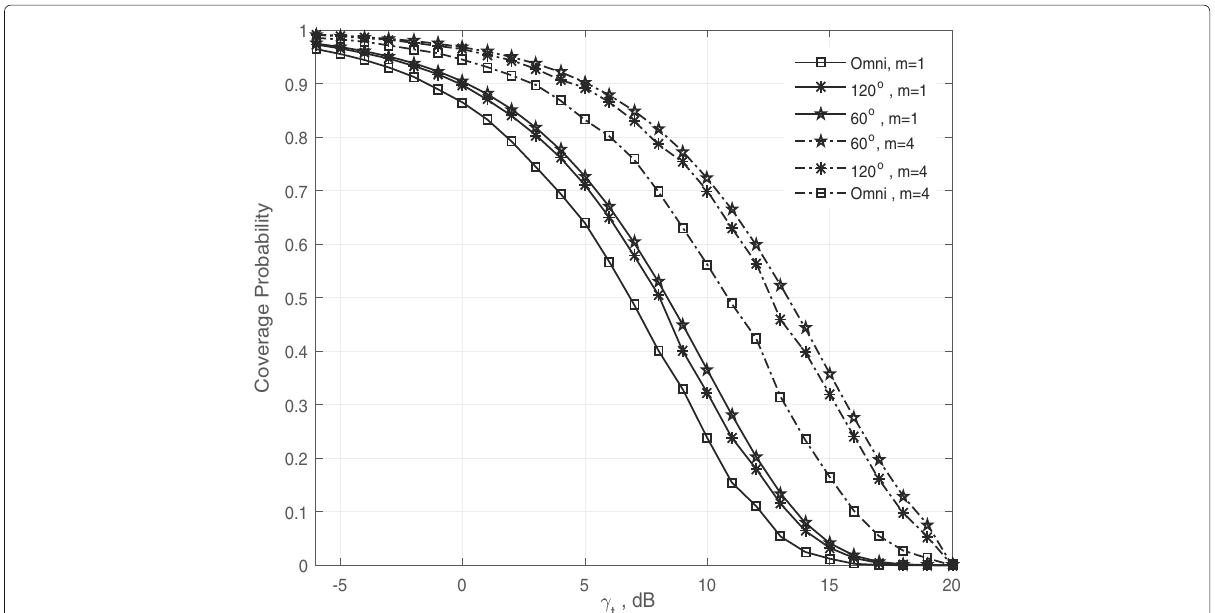
Fig. 13 Coverage probability of cellular network as a function of SNR threshold, γ t , with m = 1 and 4, γ = 10 dB, R d = 4 and α = 4 for omni, 120 ◦ and 60 ◦ antenna configurations. Coverage probability for omni antenna with m = 1 and 4, Coverage probability 120 ◦ sectorized antenna with m = 1 and 4, Coverage probability 60 ◦ sectorized antenna with m = 1 and